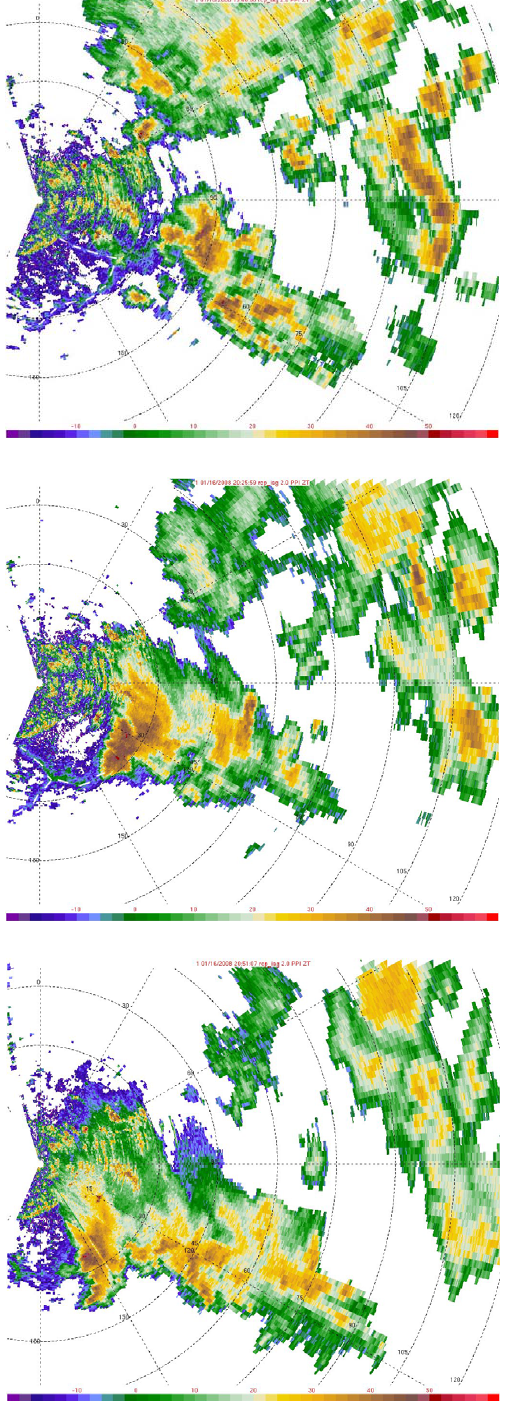
Fig. 6. 2 ◦ PPI of reflectivity ( Z h – dBZ) at 19:46UTC (a) , 20:25UTC (b) and 20:51UTC (c) obtained with MXPOL on 16 January 2008. Colour scale is indicated. Dashed white line shows the position of the moving boundaries.